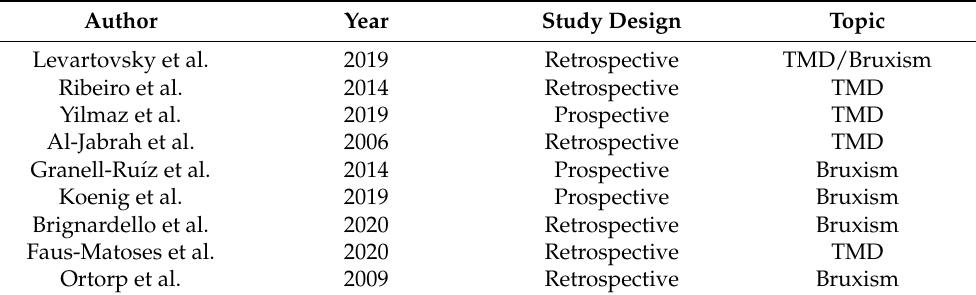
Table 1. Features of included